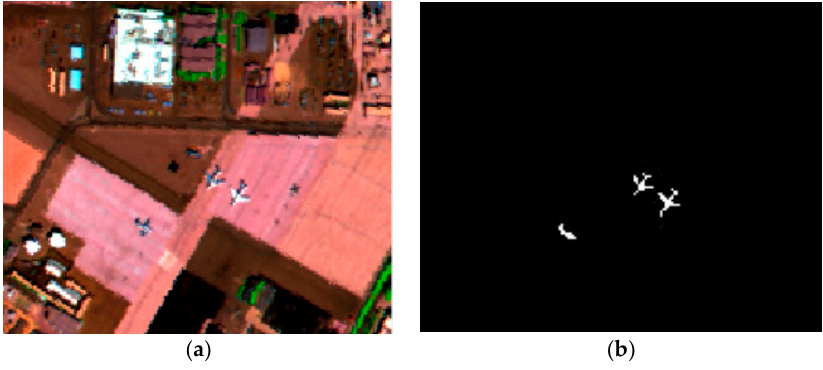
Figure 8. The image of AVIRIS: ( a ) pseudo color display of AVIRIS Dataset 1; and ( b ) reference data.